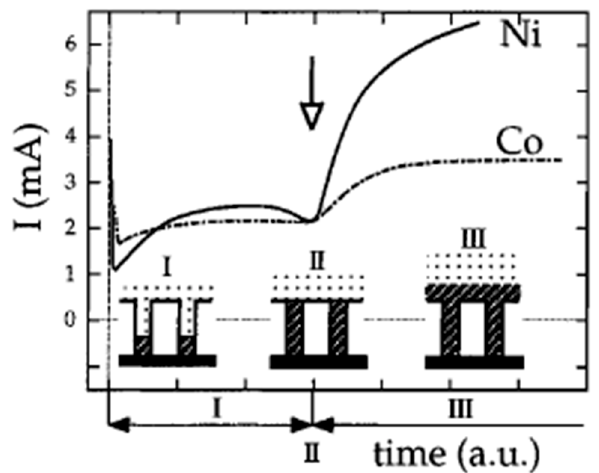
Figure 3. Electrochemical reduction current as a function of time for the potentiostatic platin of Ni and Co in the pores of PC membrane with 80 nm of nominal diameter (reprinted with permission from [24]).